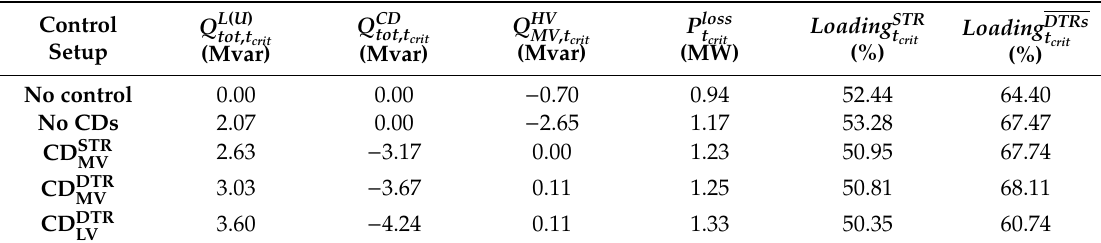
Table 2. Behaviour of the distribution grid with cable conductors in MV level at t crit for di ff erent control